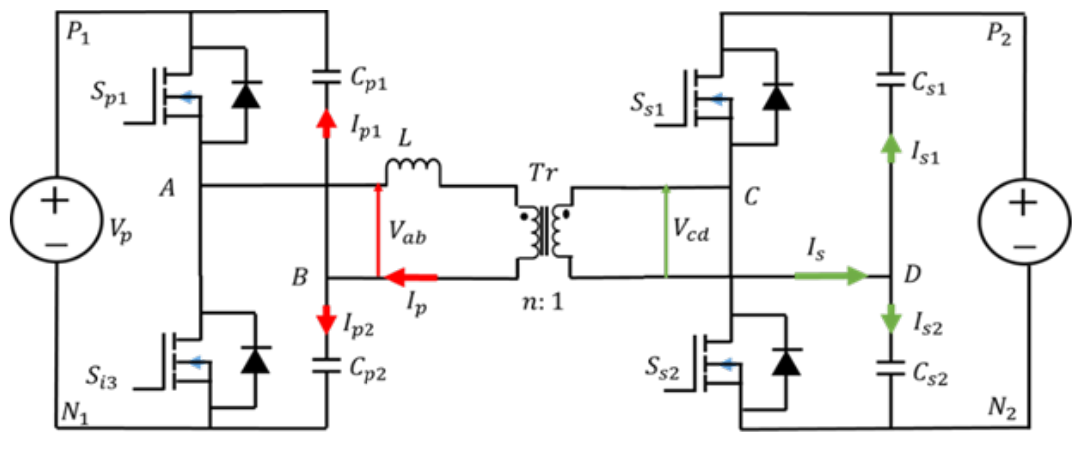
Figure 4. DAHB converter topology.